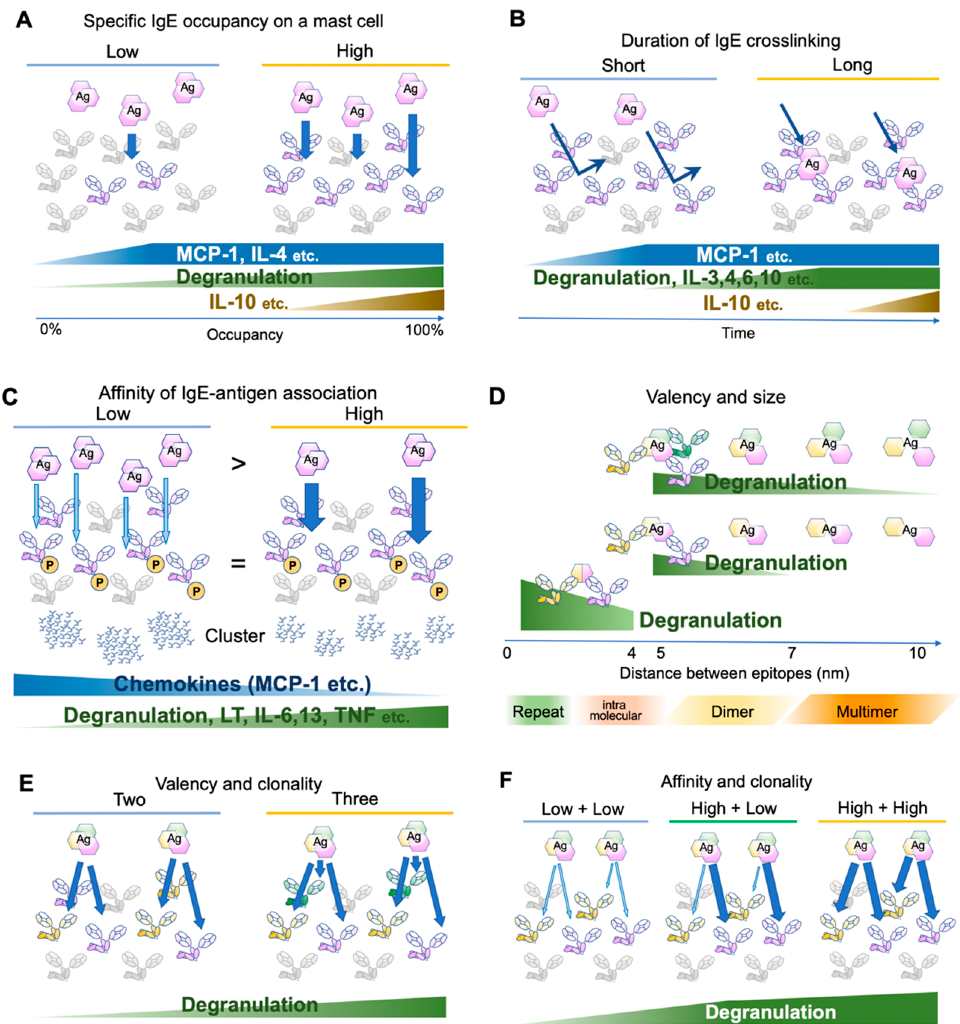
Figure 2. Differential mast cell activation by various antigens. ( A ) Effects of antigen-specific IgE occupancy on mast cell surface Fc ε RIs. ( B ) Effects of antigen-binding durations. ( C ) Effects of affinity between IgE and its cognate antigens. The antigen concentration is adjusted so that the phosphorylation levels of Fc ε RI β and γ chains are similar. Abundant low-affinity antigens induce few and large clusters, while a small amount of high-affinity antigens induce many small clusters. ( D ) Effects of spacing between antigen epitopes. ( E ) Effects of antigen valency and/or IgE clonality. ( F ) Effects of affinity of different clones against the same